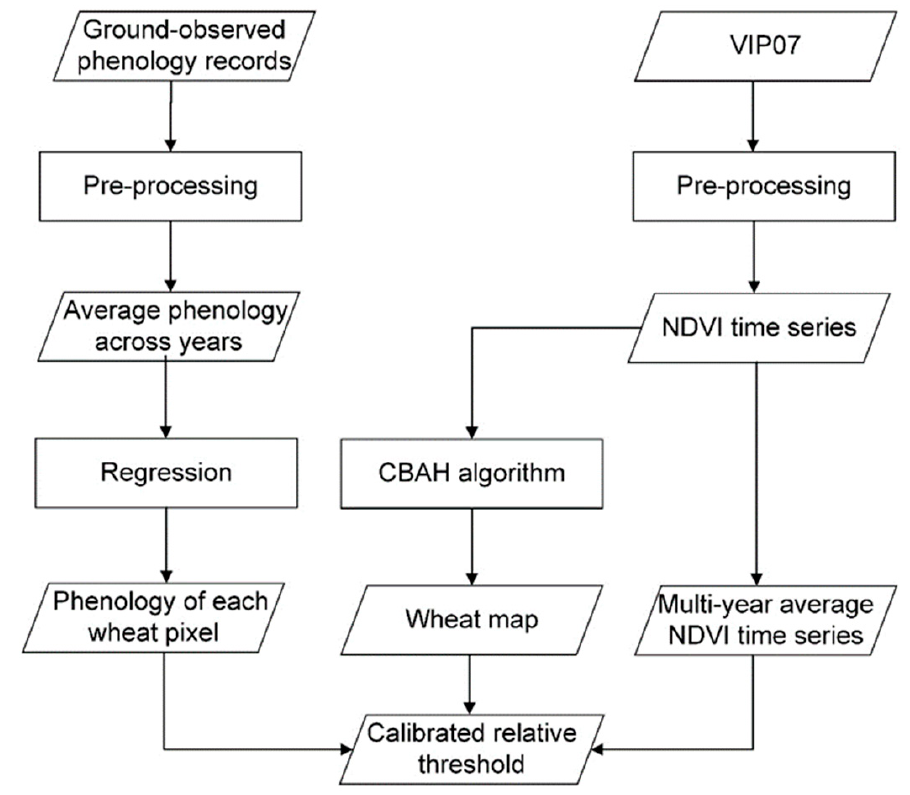
Figure 2. Flowchart of the calibrated relative threshold method (CRTM). Table 1. Regression coefficients between phenological date and elevation, longitude, and